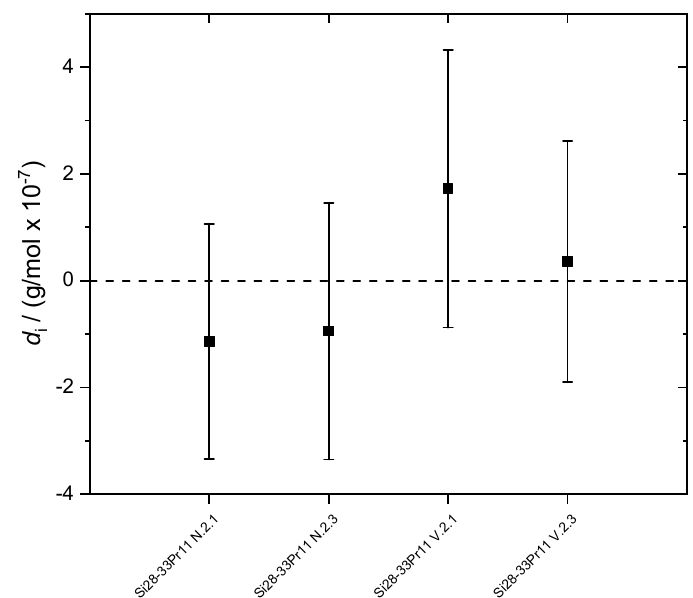
Figure 5. Degrees of equivalence d i of the four samples of the crystal Si28-33Pr11 (average molar mass without scattering). Uncertainties for k = 2. All data are consistent due to the enclosure of the zero line. Table 3. Representative uncertainty budget of sample N.2.1 (single